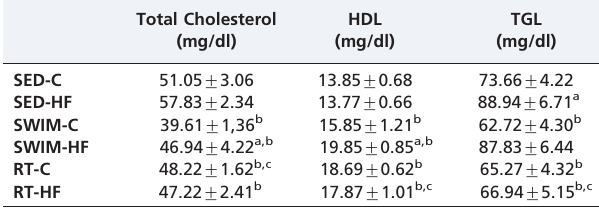
Table 3 - Total serum cholesterol, HDL and triacylglycerol